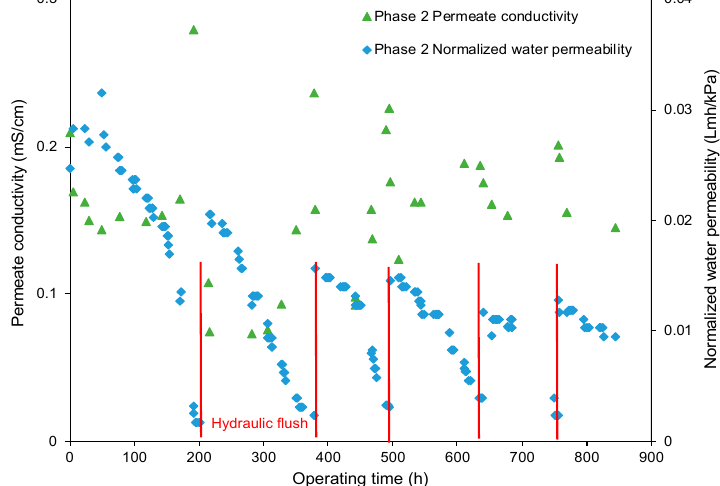
Figure 10. Permeate conductivity and Normalized water permeability during the Phase 2 experiment.